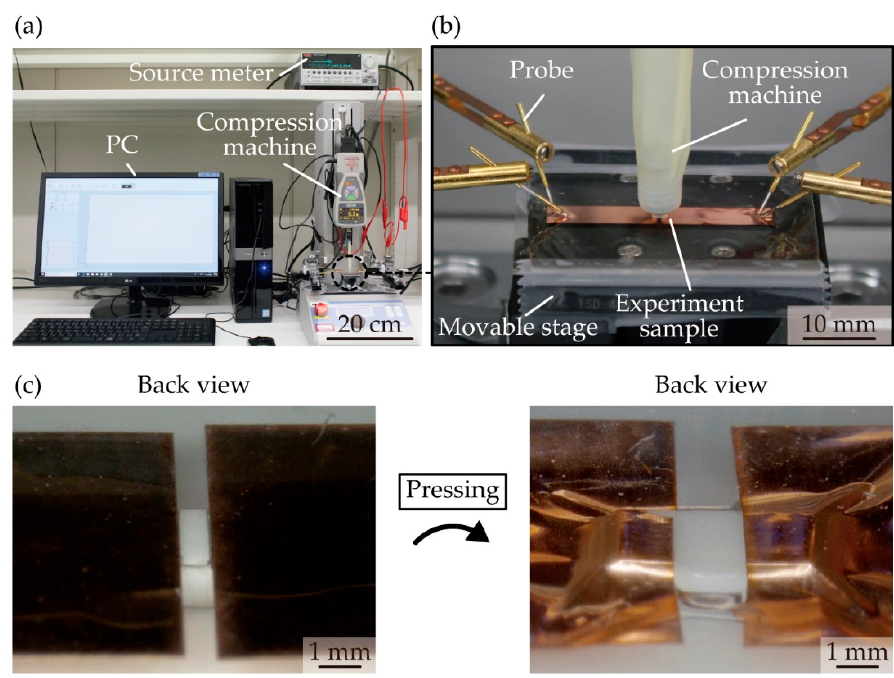
Figure 3. Optical images of experimental apparatus used to measure the change in contact resistance. ( a ) Optical image of apparatus; ( b ) optical image of enlarged view of experimental sample pressed by compression testing machine; ( c ) optical images of experimental sample with and without pushing.